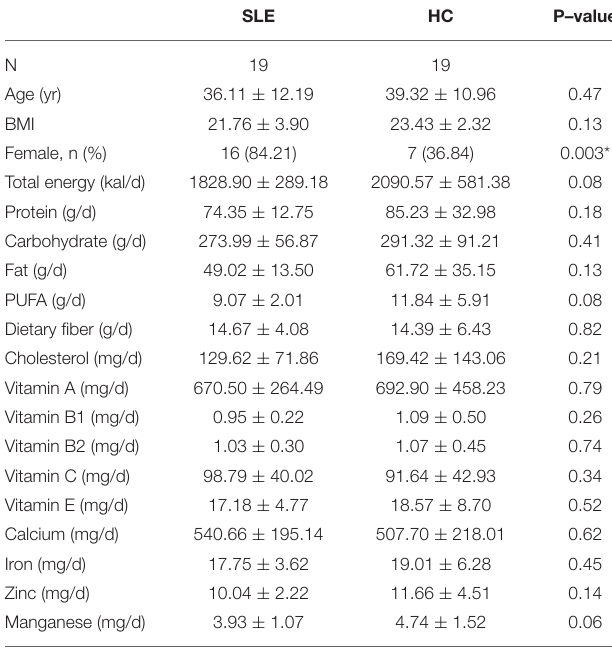
TABLE 1 | General characteristics and mean dietary intake of SLE patients and HC.